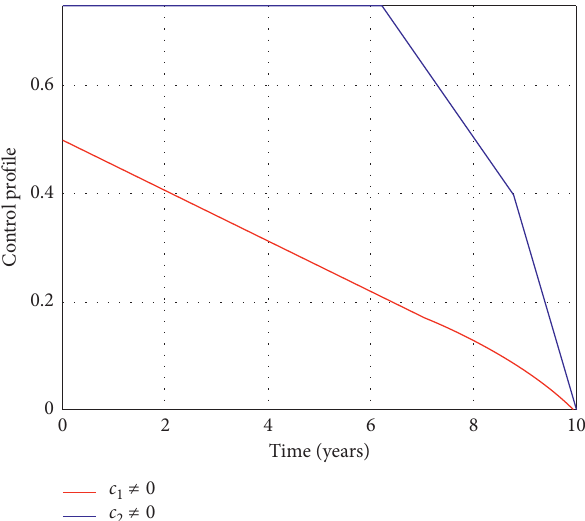
Figure 4: Control profile when c